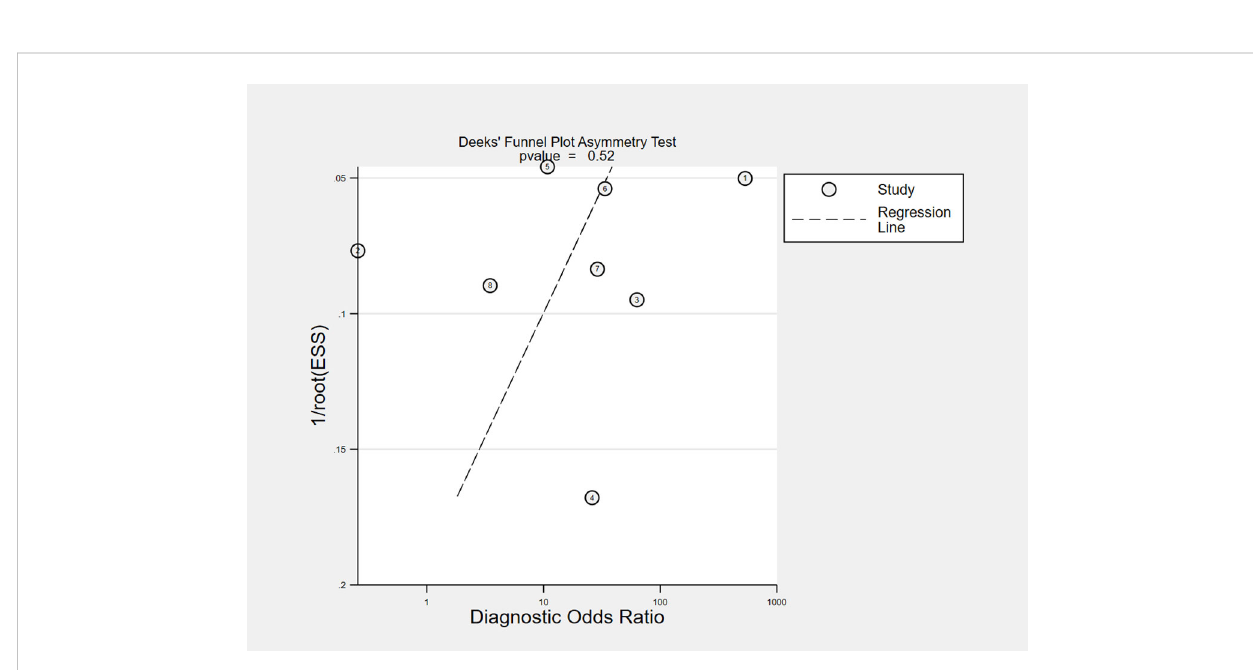
FIGURE 3 SROC of CTCs in the diagnosis of